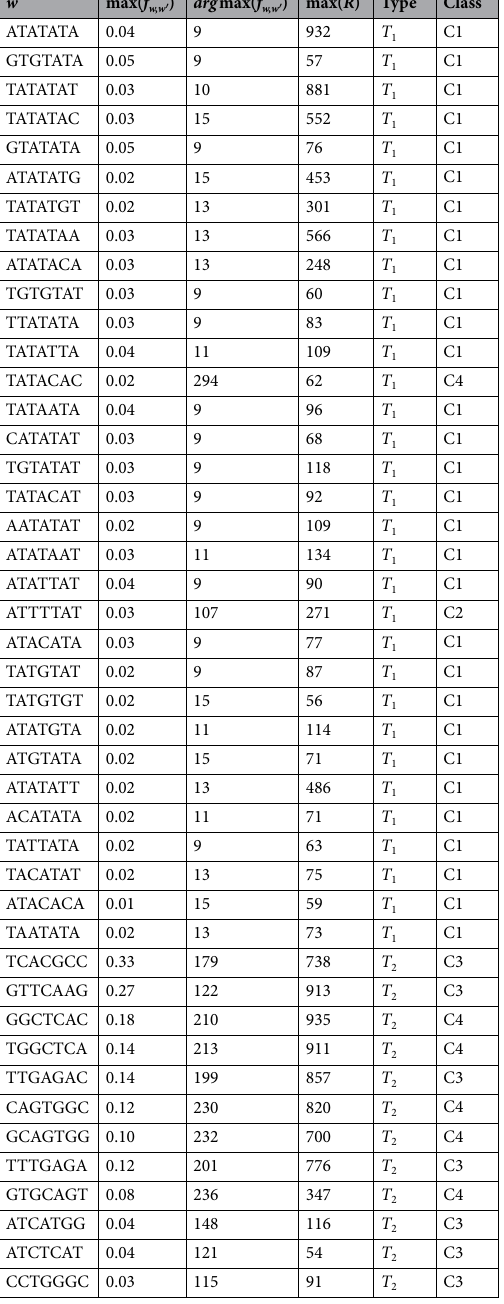
Table 1. Words of length seven with DNRC overrepresentation of short distances, identified by our procedure, with indication of DNRC distribution maximum and its argument value, discriminator R function maximum, group type ( T 1 and T 2) and class of peak distance. Distance peak classes: C 1 ( d < 100), C 2 ( d ≈ 100), C 3 (100 < d < 200) and C 4 ( d >